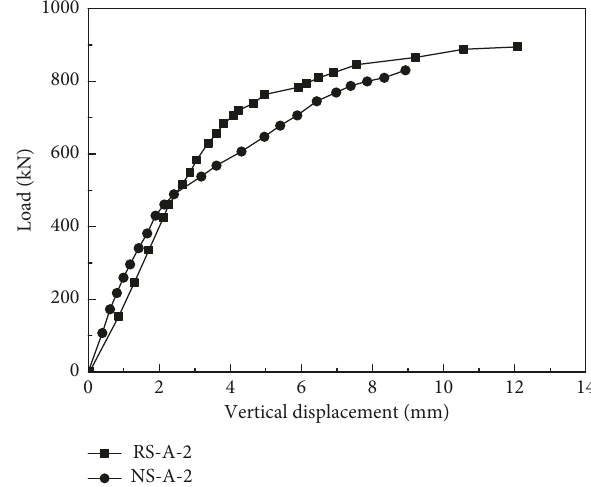
Figure 7: Vertical displacement-load curves of two thickness steel tube-reinforced CFST piles.